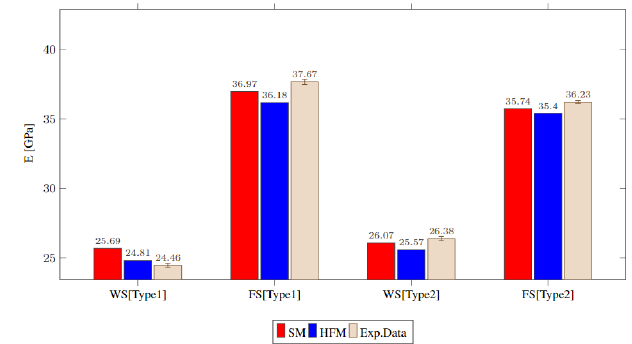
Figure 10. Stiffness results for wrinkles type 1 and type 2 around the wrinkle section (WS) and the flat section (FS) based on the nu- merical model predictions and experimental